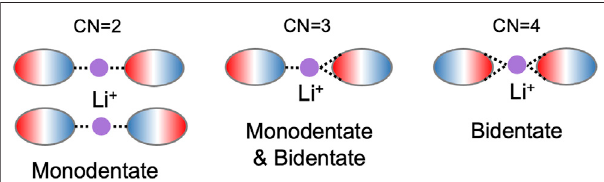
FIGURE 1 | Representative coordination environments for Li + with two asymmetric solvating anions forming bidentate and/or monodentate bonds. Li + isrepresentedbythepurplecircleandtheasymmetricanionisrepresented bytheovals,withredandbluecolorcodescorrespondingtothedifferent coordination sites.